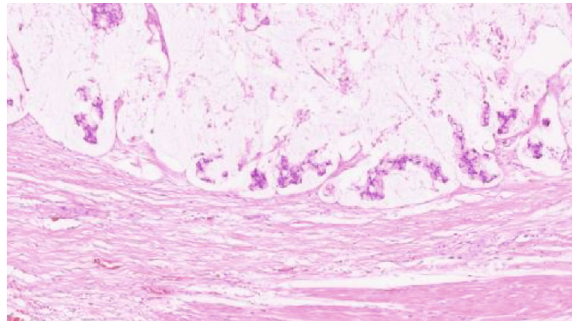
Figure 5: Predominant mucinous adenocarcinoma, with strands of glandular cells fl oating in abundant extracellular